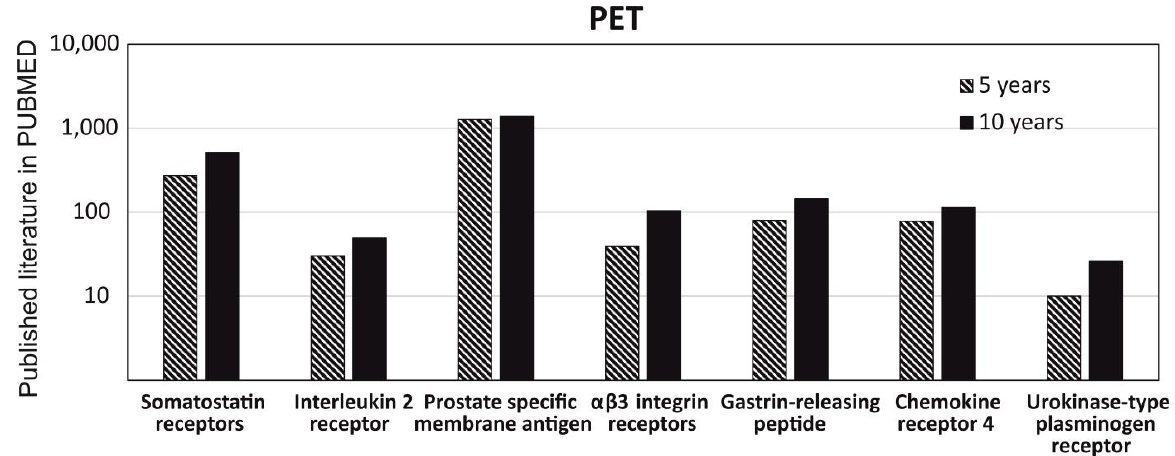
Figure 6. Understanding the role of radiolabeled peptide in PET through the published literature on PUBMED in the last 5 years and 10 years. Comparison of the data published with different keywords, such as somatostatin receptors, interleukin 2 receptor, prostate specific membrane antigen, αβ 3 integrin receptor, gastrin-releasing peptide, chemokine receptor 4, and urokinase-type plasminogen receptor.